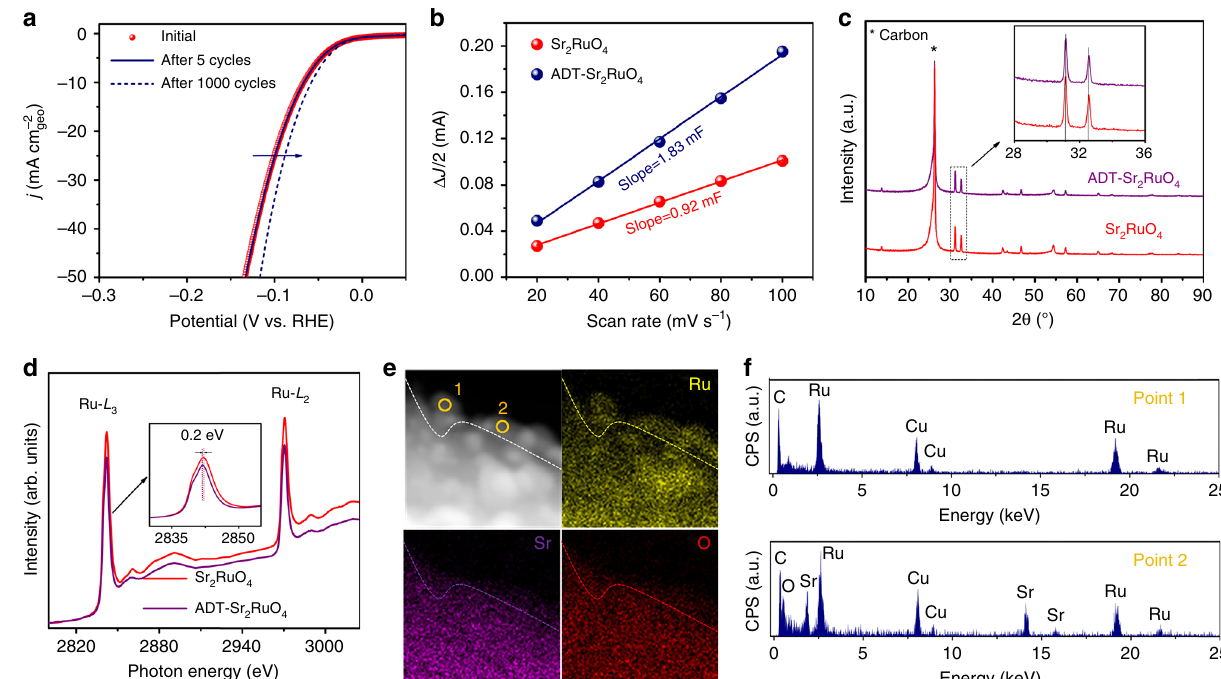
Fig. 4 Electrochemical activation of Sr 2 RuO 4 by ADT. a Polarization curves of Sr 2 RuO 4 catalyst initially, as well as after 5 and 1000 cycles. b Linear fi tting curves of the capacitive currents versus CV scan rates for Sr 2 RuO 4 and ADT-Sr 2 RuO 4 . c XRD patterns of Sr 2 RuO 4 and ADT-Sr 2 RuO 4 loaded on the carbon paper substrate. Insert is the magni fi ed XRD patterns showing main peaks of Sr 2 RuO 4 and ADT-Sr 2 RuO 4 . d Ru- L 2,3 XAS spectra of Sr 2 RuO 4 and ADT- Sr 2 RuO 4 . Insert is the magni fi ed Ru- L 3 spectra of Sr 2 RuO 4 and ADT-Sr 2 RuO 4 . e HAADF-STEM image and the corresponding EDX elemental mapping of ADT-Sr 2 RuO 4 . f EDX spectra at the position in points 1 and 2 in ( e